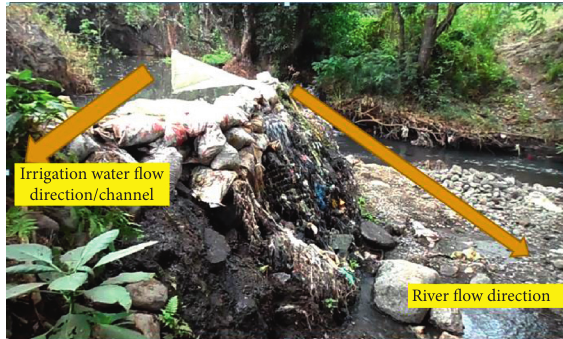
Figure 5: Furrow intake constructed with sand bag/stone/trees